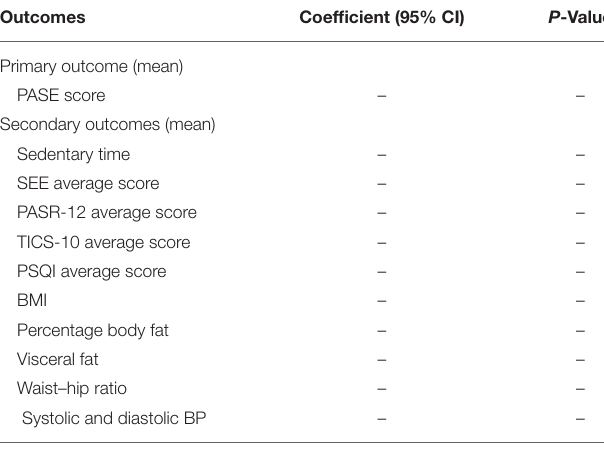
TABLE 1 | Characteristics of eligible participants. TABLE 2 | Coefficients of difference-in-difference regression